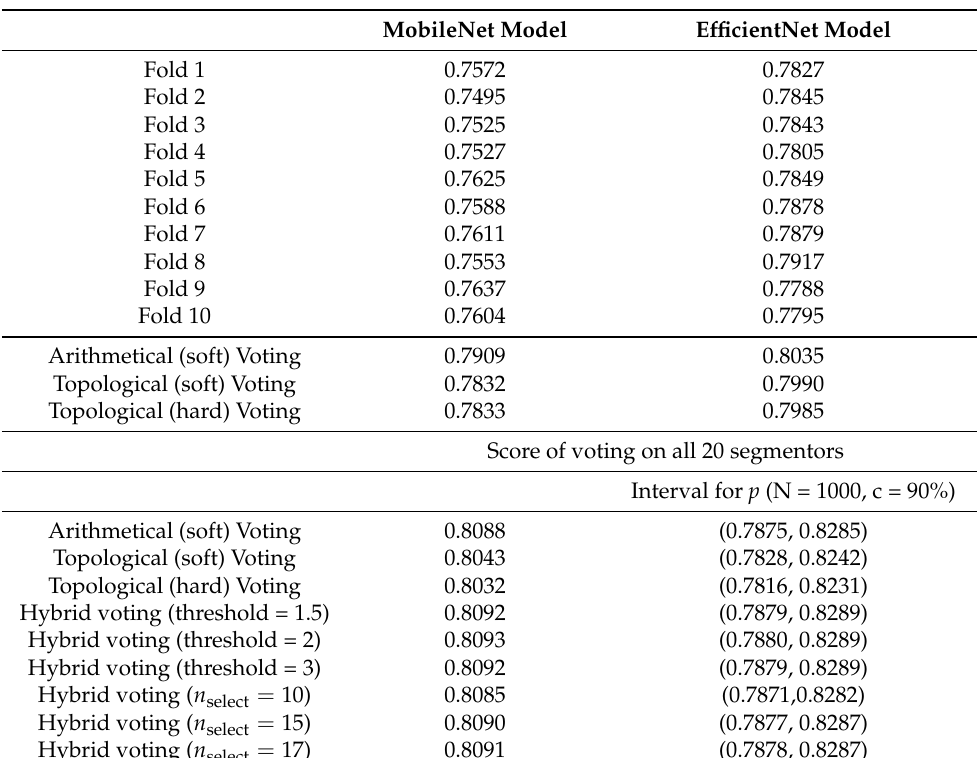
Table 4. Comparison of voting methods on 10 folds for the Face